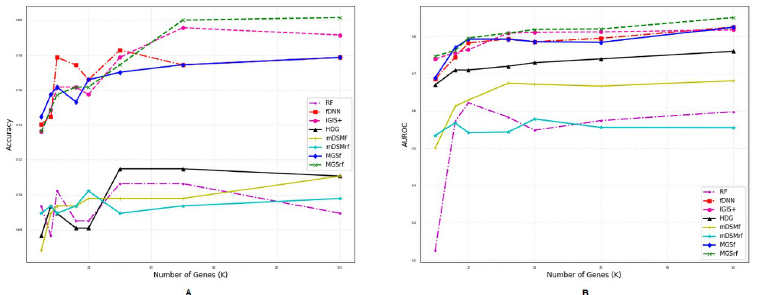
Fig 7. Performance comparison using different number of selected genes for the GSE106291 dataset. (A) Accuracy. (B) AUROC.